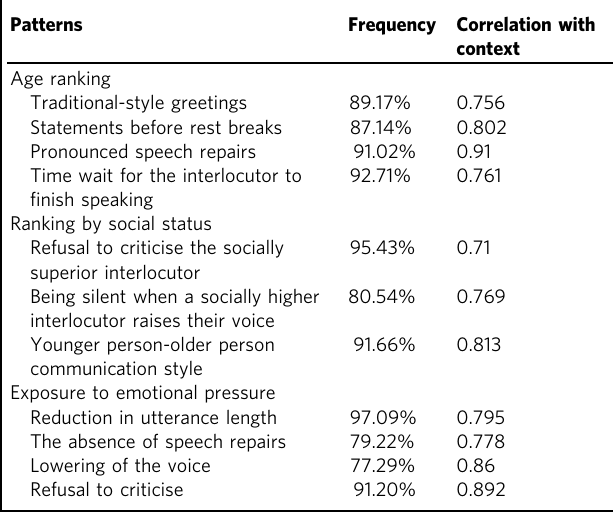
Table 2 The frequencies of behavioural patterns (the percentage of utterances in the corpus) and their correlation with the context of the conversation.